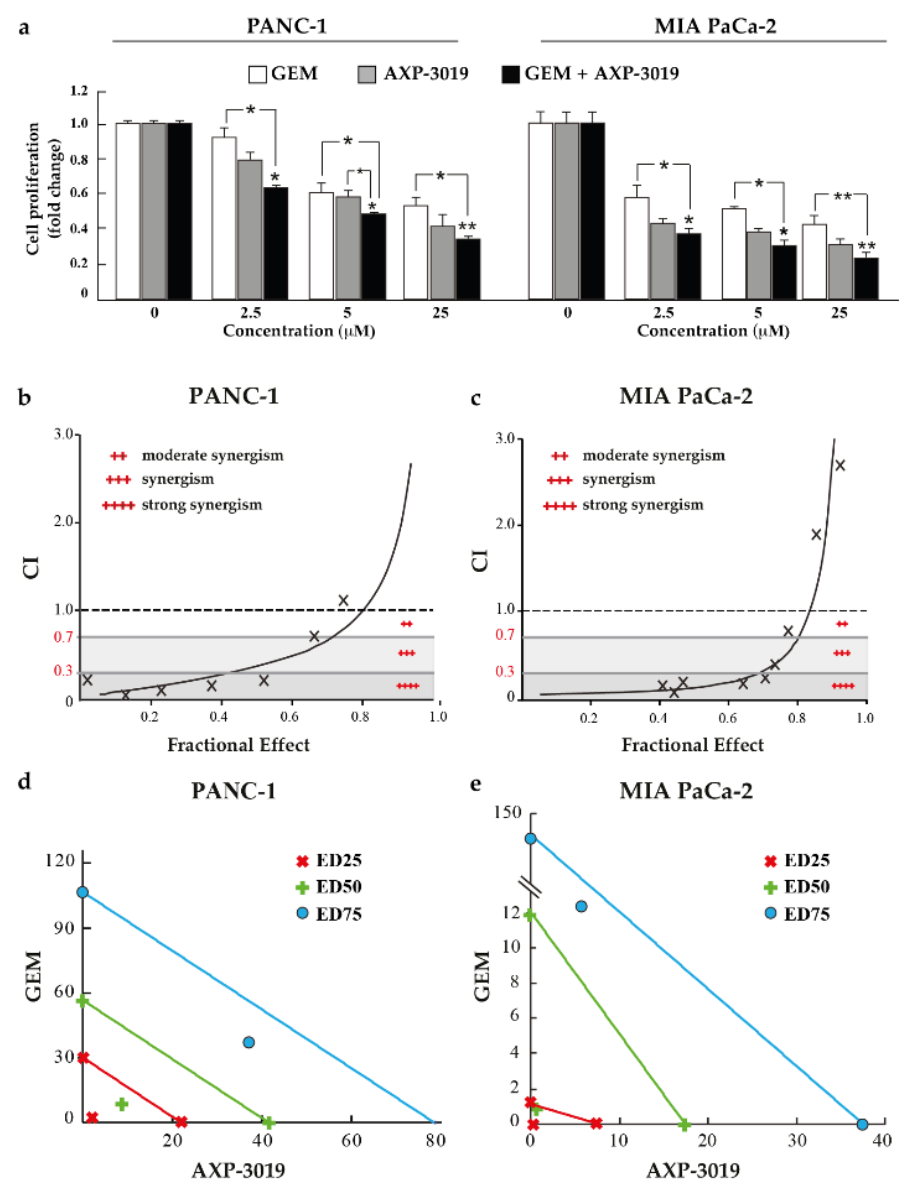
Figure 7. Synergistic inhibition after treatment with AXP-3019 and gemcitabine. PANC-1 and MIA PaCa-2 cell lines were seeded in 96-well plate and were treated with increasing concentrations of AXP-3019 and GEM. ( a ) Cell proliferation after treatments with AXP-3019 and GEM, alone or in combination of them (1:1 molecular ratio). ( b , c ) Combination index (CI) versus fractional effect (i.e., the percentage of cell growth inhibition in combined setting). ( d , e ) Isobologram graphs using IC 25 , IC 50 , and IC 75 values indicate the equipotent combination of the two drugs and can be used to analyse synergism, additivity, or antagonism. Statistical analysis * p < 0.05; ** p < 0.001. Table 2. Combination index (CI) and dose-reduction index (DRI) values of GEM + AXP- 3019 combination on PDAC cell lines after 48 h of treatment.